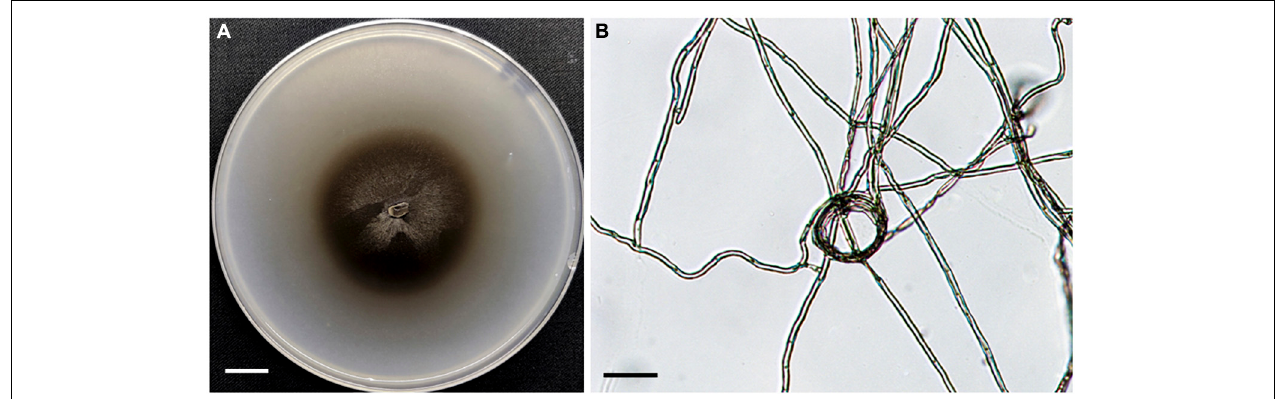
FIGURE 2 | Maximum-likelihood tree constructed using rDNA-ITS sequences of HB3-1 generated in this study and reference sequences downloaded from GenBank. Known dark septate endophytes (DSE) are marked in bold. DSE detected in orchids (Girlanda et al., 2002; Hou and Guo, 2009; Valdés et al., 2011; Sebastián et al., 2014; Zhao et al., 2014) were marked by the orchid names in brackets. The values of the bootstrap frequencies (BP > 70%) are shown beside the nodes.